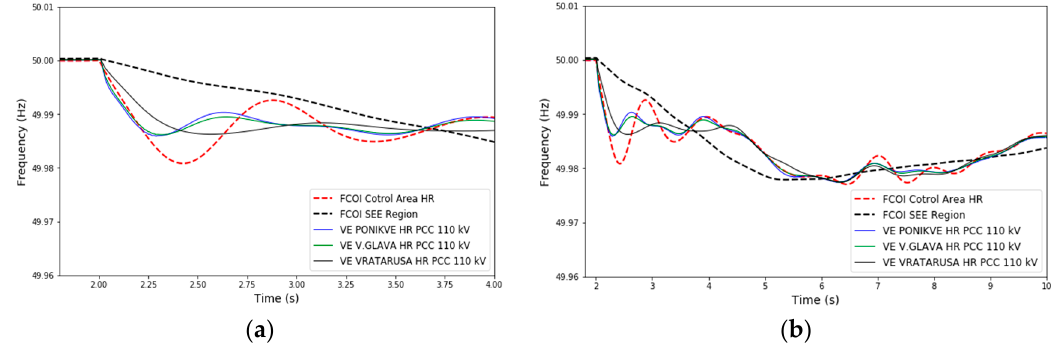
Figure 12. EPS frequency response. ( a ) simulation time 4 s, ( b ) simulation time 10 s.